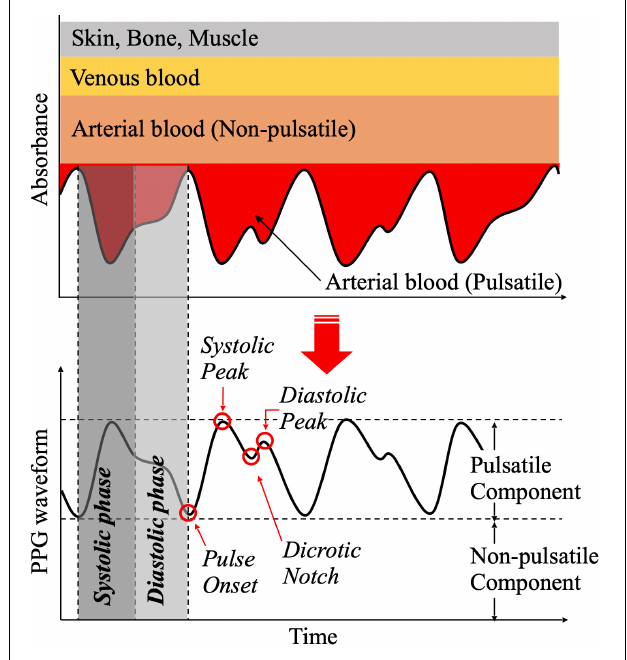
FIGURE 3 | Principle of phototoplethysmogram generation and waveform